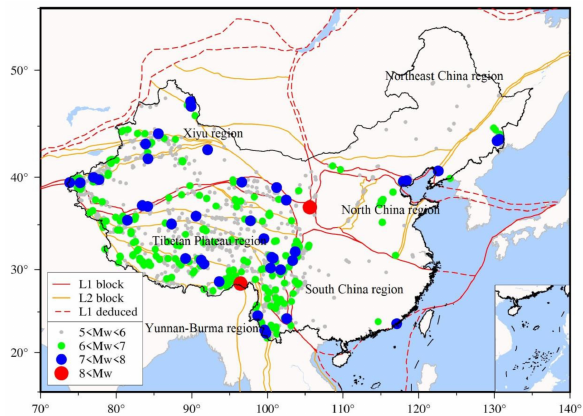
Figure 1. Spatial distribution of earthquakes (Mw ≥ 5) in continental China during the period of 1900 to